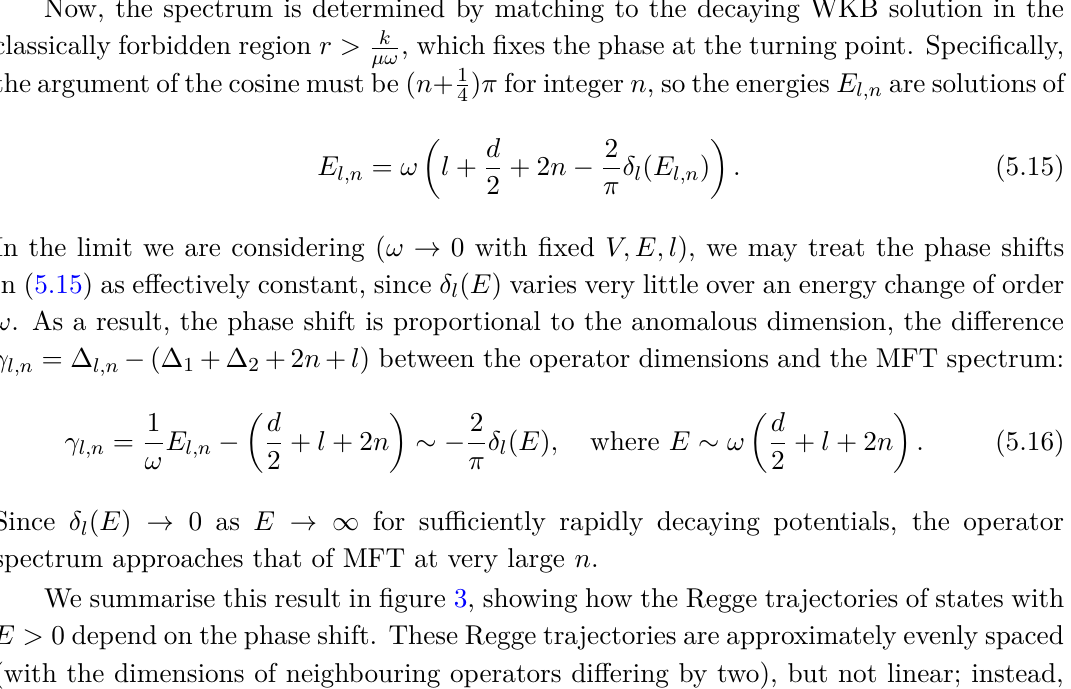
Figure 3 . An illustration of the relation between the scattering phase shift δ l ( E ) and the spectrum E l,n in AdS. For an example potential, on the left we plot − 2 energies and on the right we plot the AdS spectrum, with the free spectrum E l,n = d indicated by the dashed straight lines. The shape of the Regge trajectories on the right follows the plots of the phase shift on the